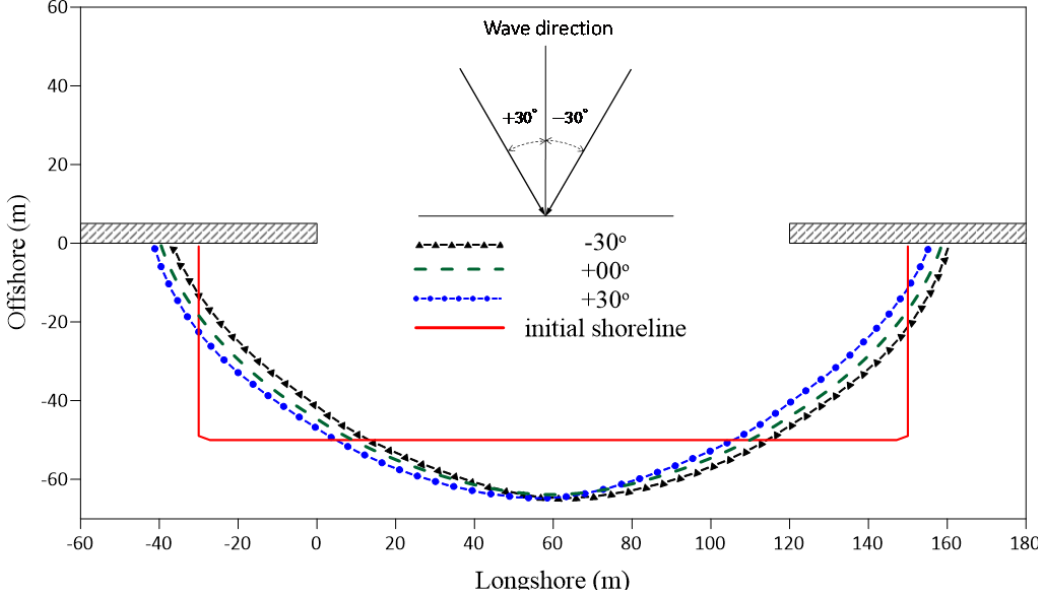
Figure 11. The profile of steady-state shorelines by adopting three different angles of incident wave. (m = 179, ∆ t = 0.01 sec